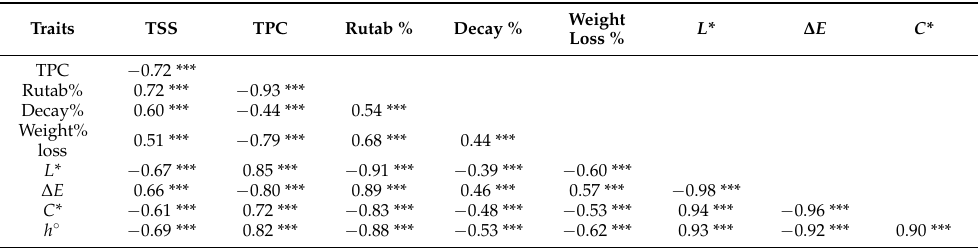
Figure 2. Effects of preharvest treatments with natural elicitors on “Barhi” fruit’s total soluble solids during cold storage for two months; values are the mean (n = 3) ± SE. Means with the same letter(s) between treatments within storage time intervals (small letter) and at different time intervals (capital letter) are not significantly different. Ch: chitosan; SA: salicylic acid; Ca: calcium chloride. Table 2. Pearson’s correlation coefficients between some physical and biochemical properties of “Barhi” fruit. TPC: total phenolic content; TSS: total soluble